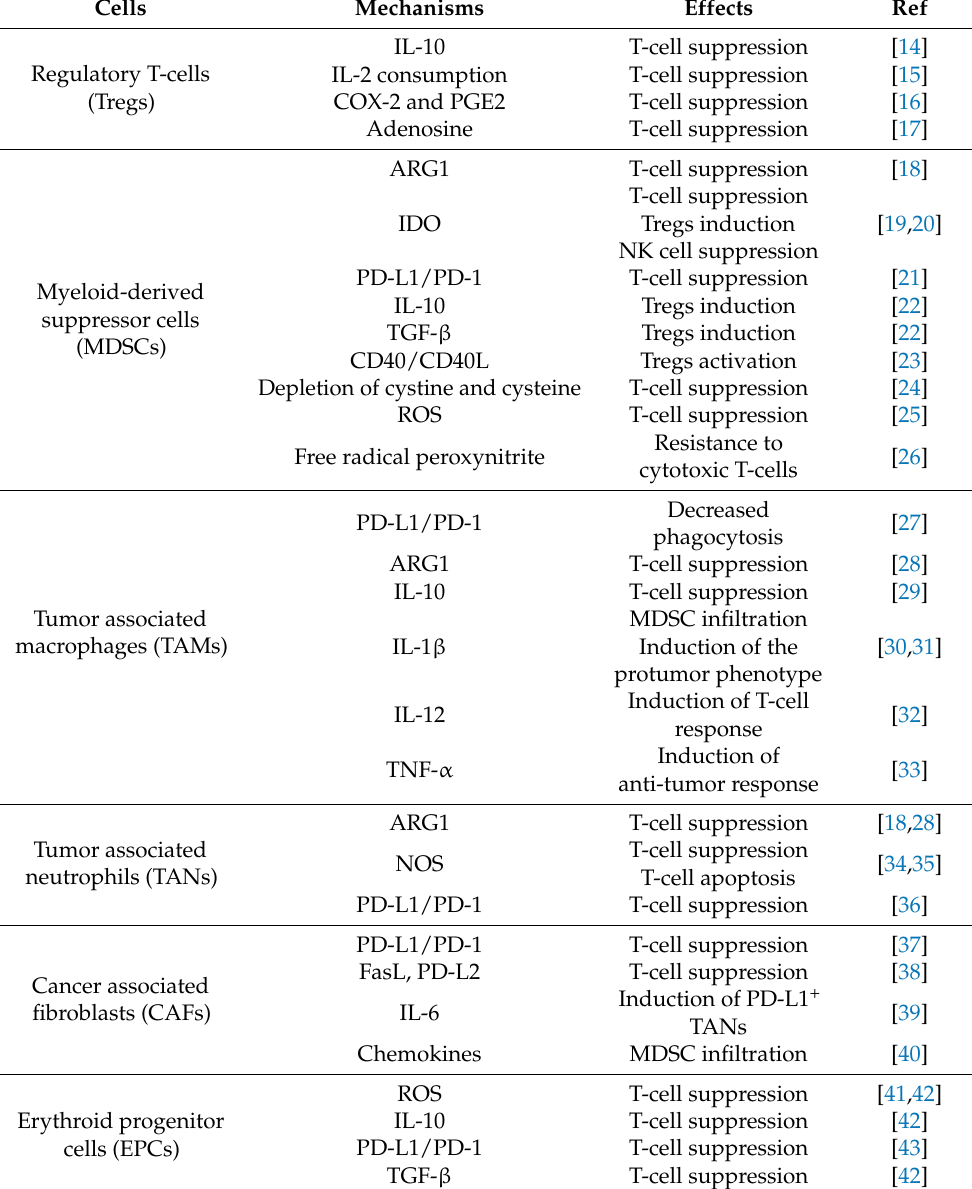
Table 1. Immunomodulatory cells in cancer and their mechanisms of immune